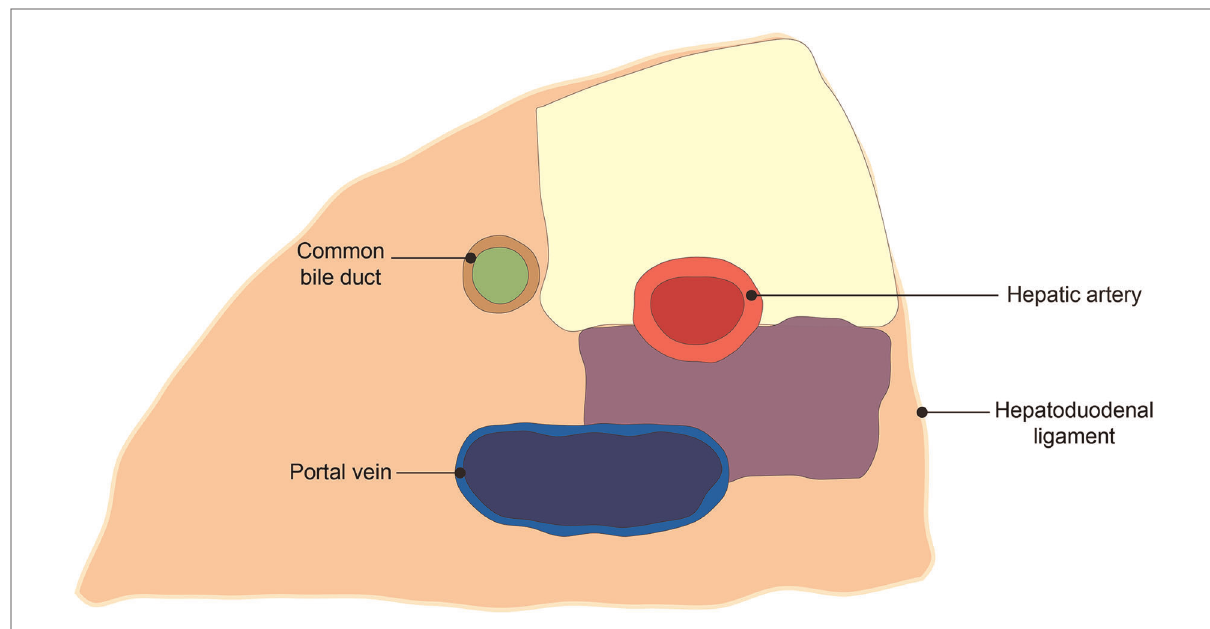
FIGURE 4 Schematic diagram of the scope of 12a lymph node dissection. The yellow area is the experimental group, and the yellow plus purple area is the control